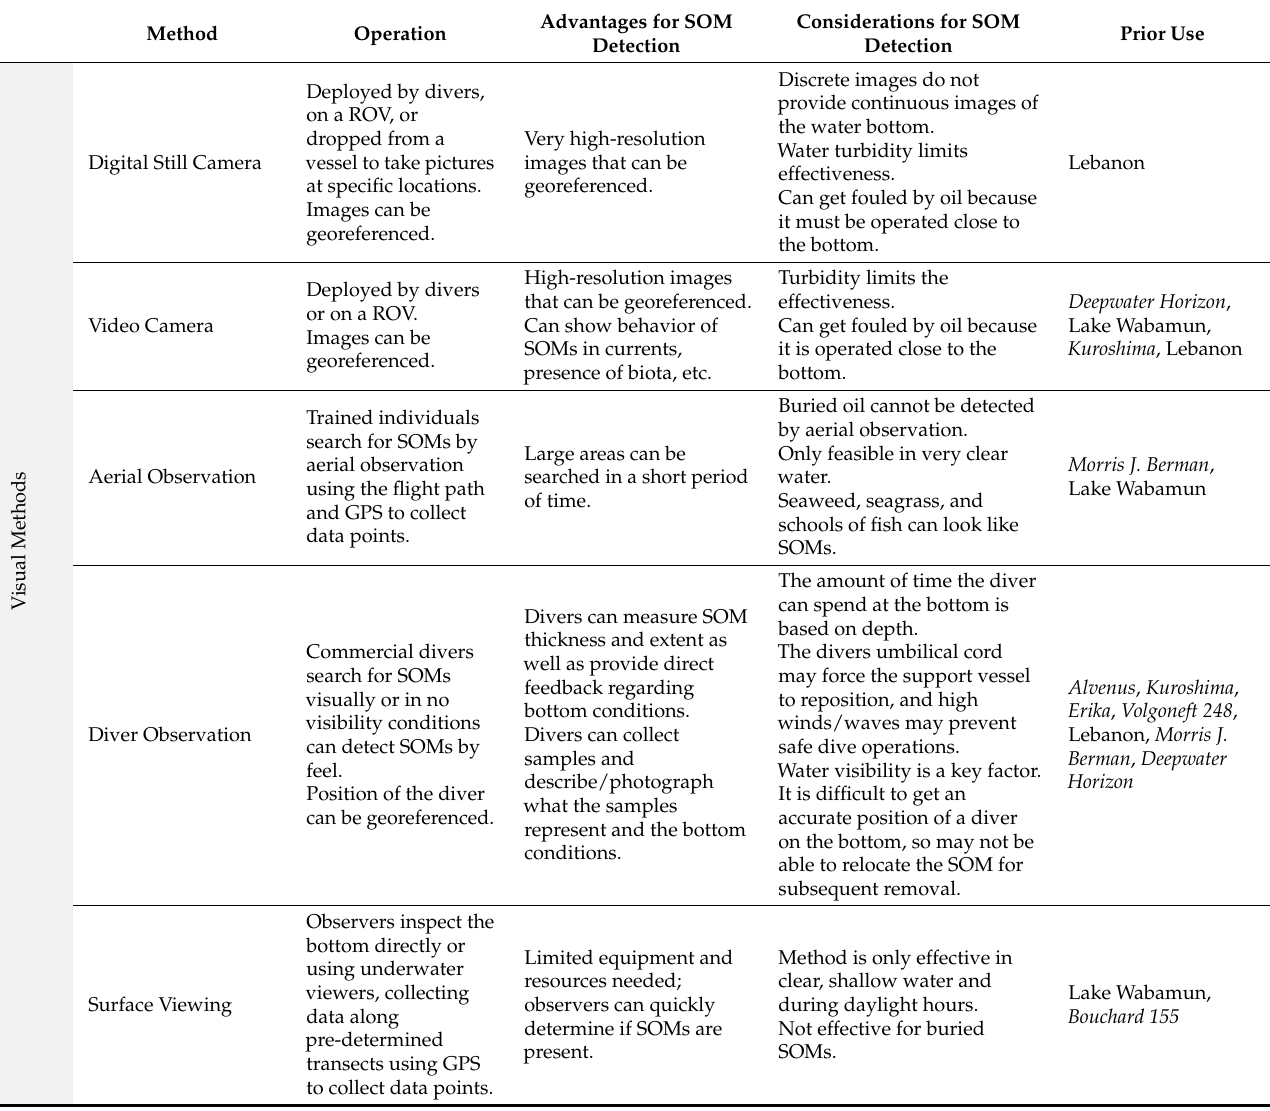
Table 3. SOMs detection using visual methods for open-water environments seaward of the surf